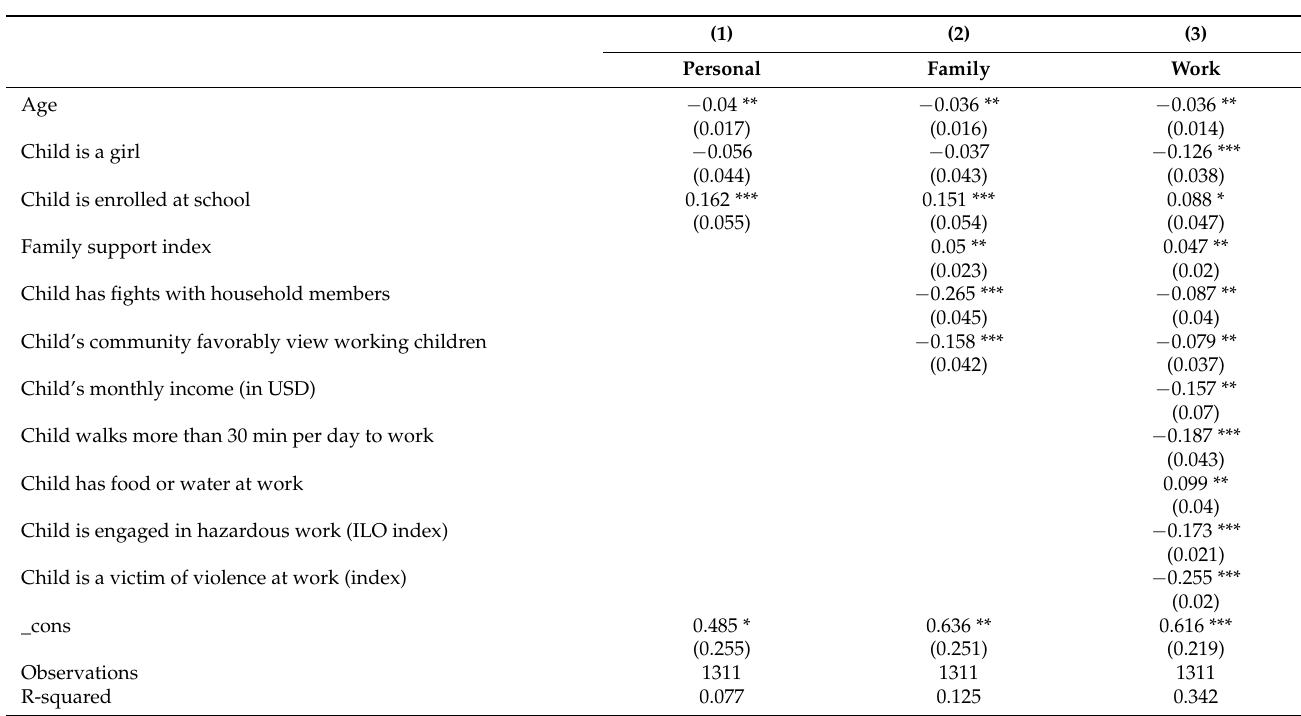
Table A7. Linear regressions for stress